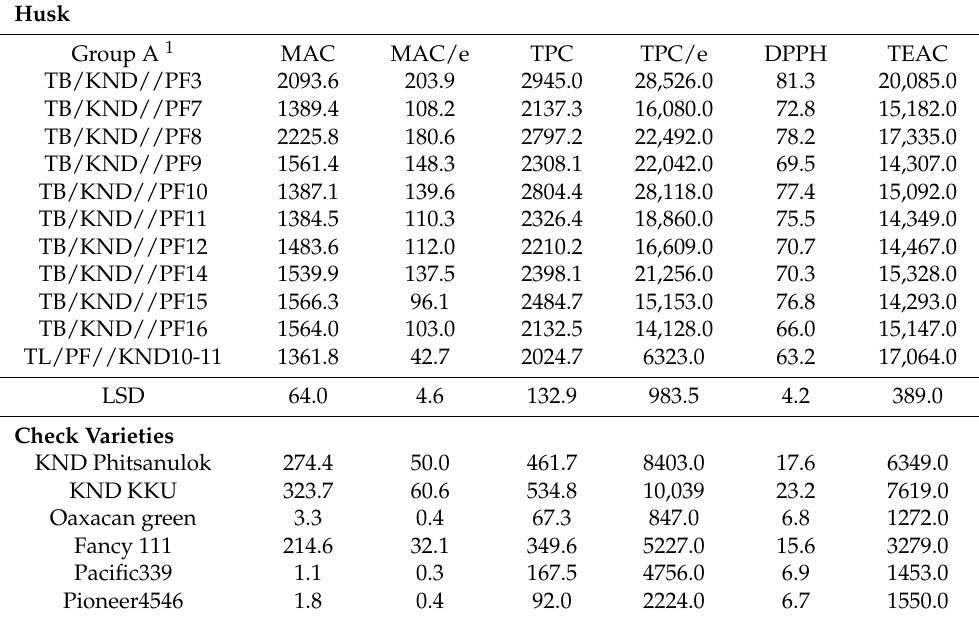
Table 3. Means for monomeric anthocyanin content, total phenolic content, and antioxidant